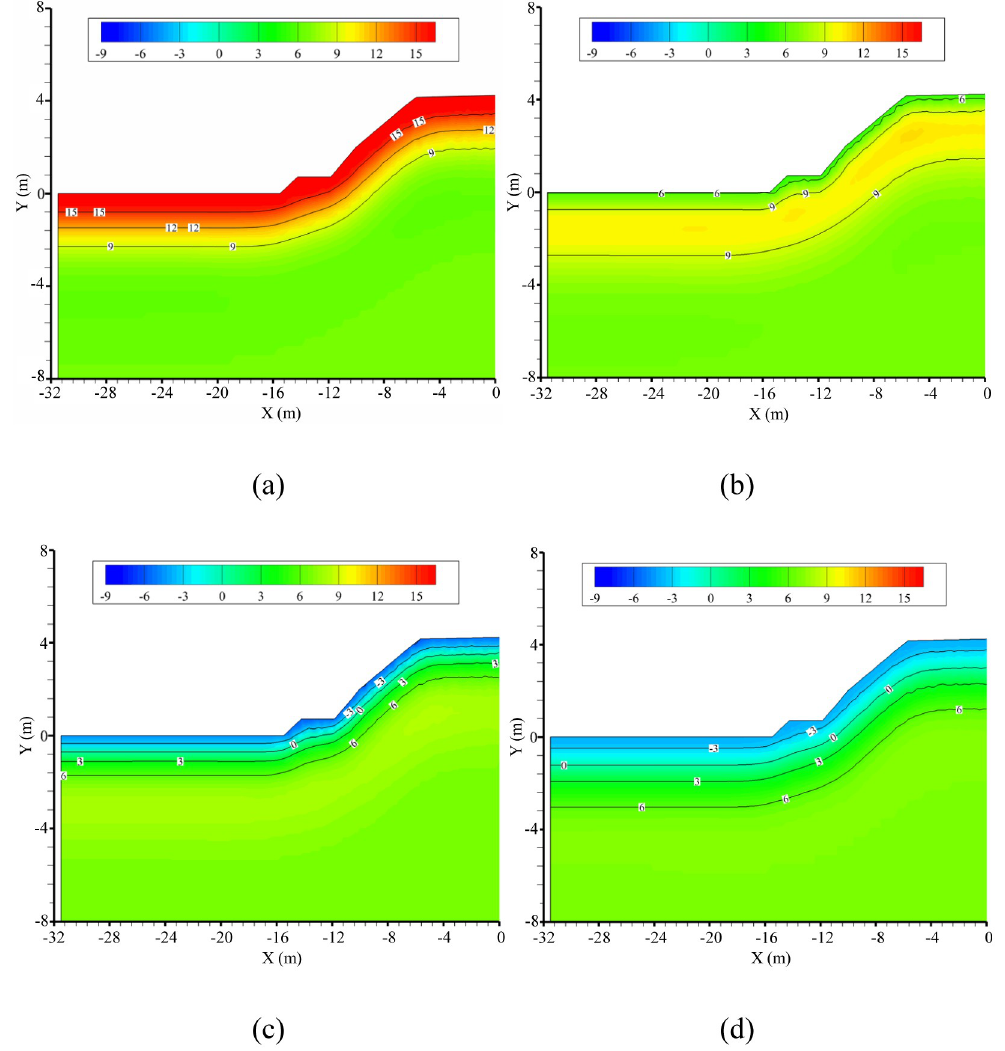
Fig 12. Modeled temperature (˚C) distribution within the railway embankment in the 10 th year after construction on (a) October 1, (b) December 1, (c) February 1, and (d) April 1.